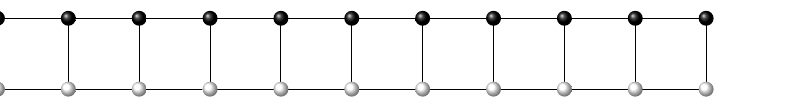
Figure 3. A minimum doubly connected dominating set of G [ 11,2 ] formed by the set of all black